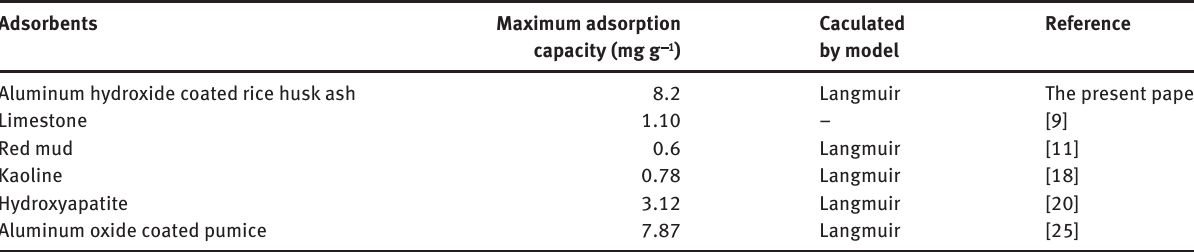
Table 2: The maximum fluoride adsorption capacity of various adsorbents obtained from nature. Adsorbents